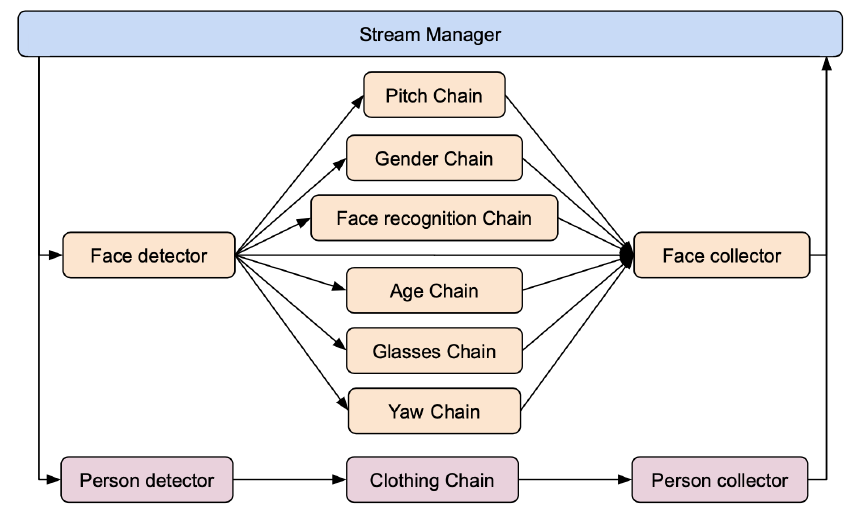
Figure 11. Composition of the processing pipelines for the customer intelligence application.